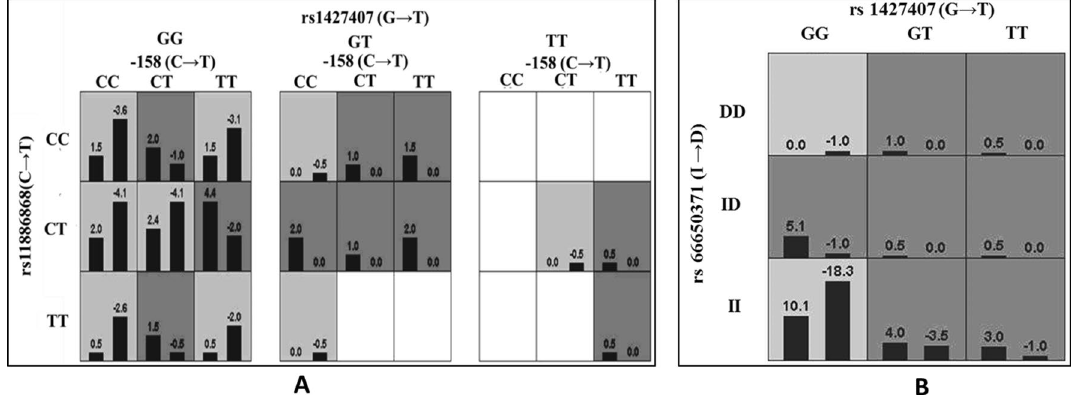
Figure 3. SNP tile analysis of gene–gene interaction in β-hemoglobinopathy patients. The tiles are shaded according to the cumulative scores of both the bars. Here the dark grey tiles represent a positive score (presence of mutant HbF boosting allele in milder patient group) and the light grey tiles represent a negative score (presence of normal allele in the severe patient group). ( A ) The mutant alleles of 3 SNPs (XmnI polymorphism, rs11886868(C → T) and rs1427407 (G → T) found to be significantly higher in β-thalassemia intermedia patients (the left bar) as compared to the β-thalassemia major patients (right bar). ( B ) The mutant alleles 2 SNPs [rs66650371 [TAC (I) > deletion of 3 bp (D)] and rs1427407 (G → T)] found to be significantly higher in SCA patients with HbF levels > 17.4% (left bar) as compared to the SCA patients with HbF ≤ 17.4% (right